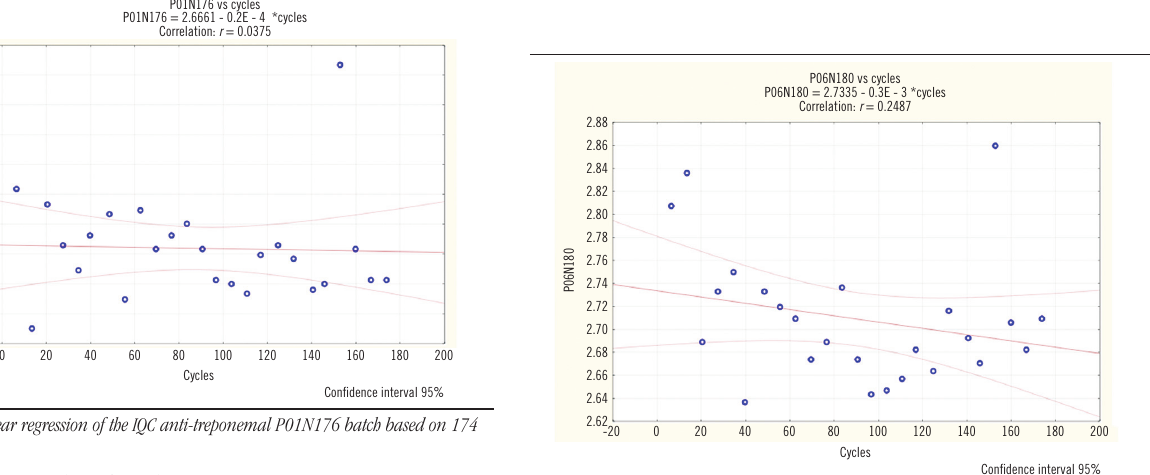
figurE 3 − Linear regression of the IQC anti-treponemal P04N178 batch based on 174 cycles of F/T IQC: internal quality control; F/T: freeze/thaw.